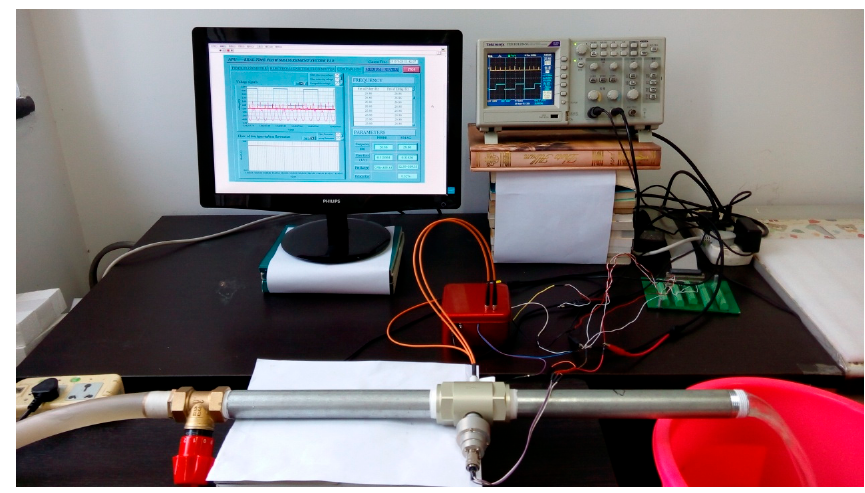
Figure 8. The flow measurement system laboratory test photo.